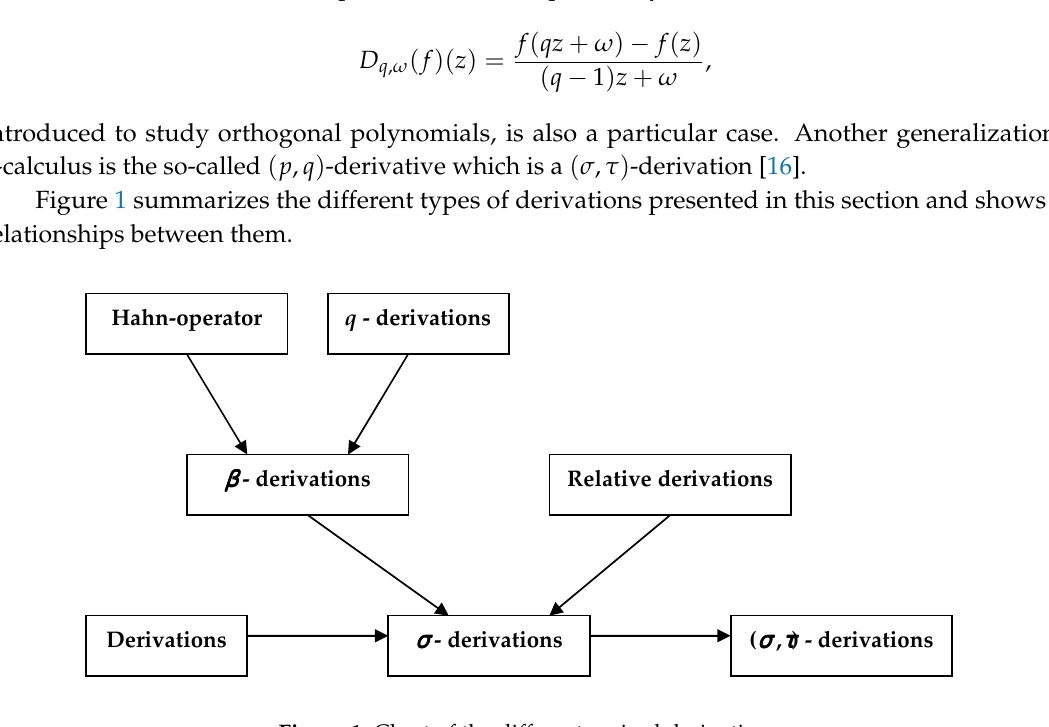
Figure 1. Chart of the different revised